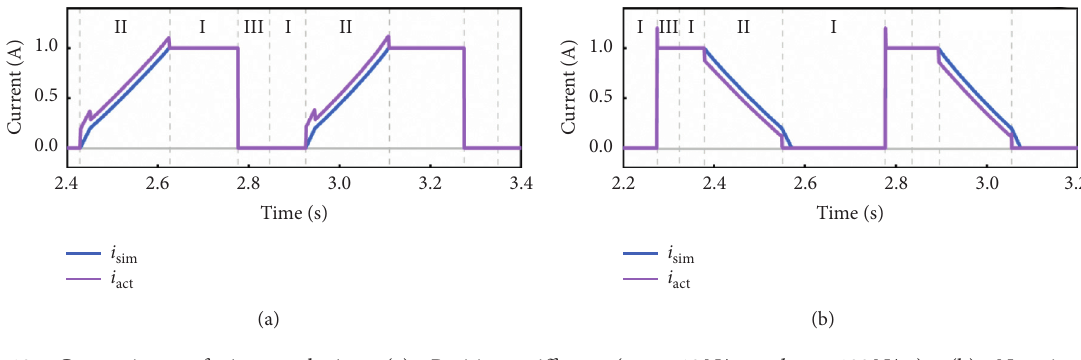
� 10N/m · s , k � 100N/m). (b) Negative stiffness des des